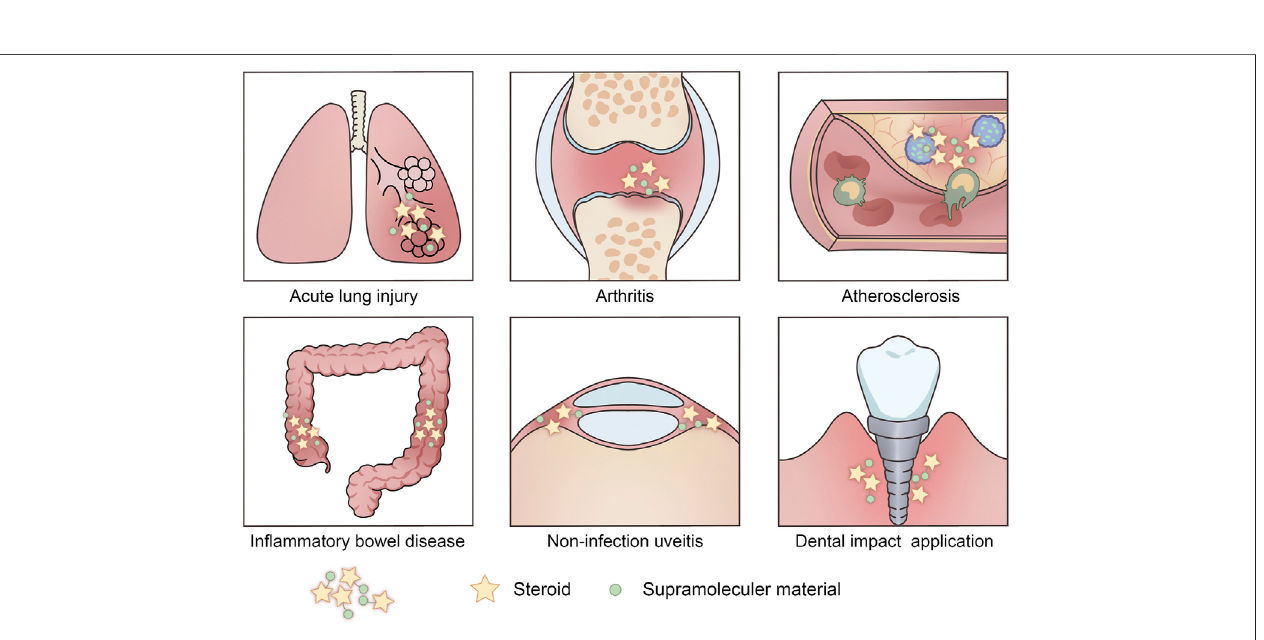
Frontiers in Molecular Biosciences |